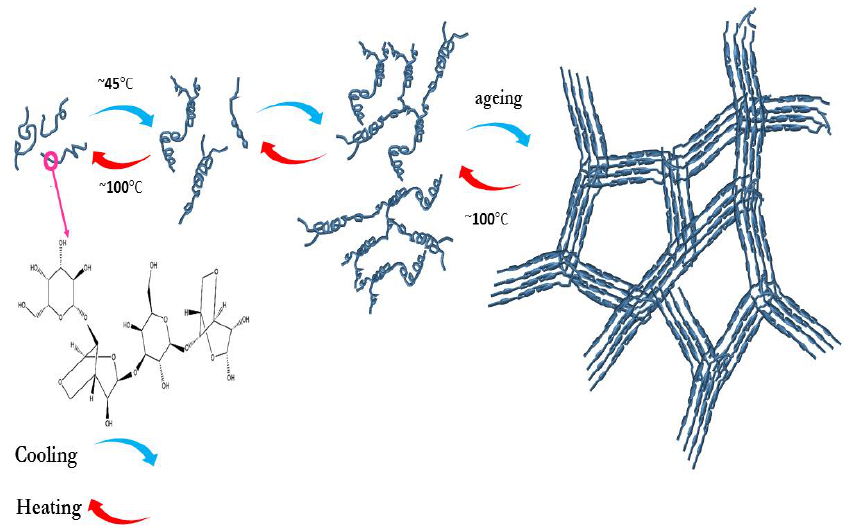
Figure 4. The molecular structure of agarose and schematic of its gelling process (reprinted from [21]).